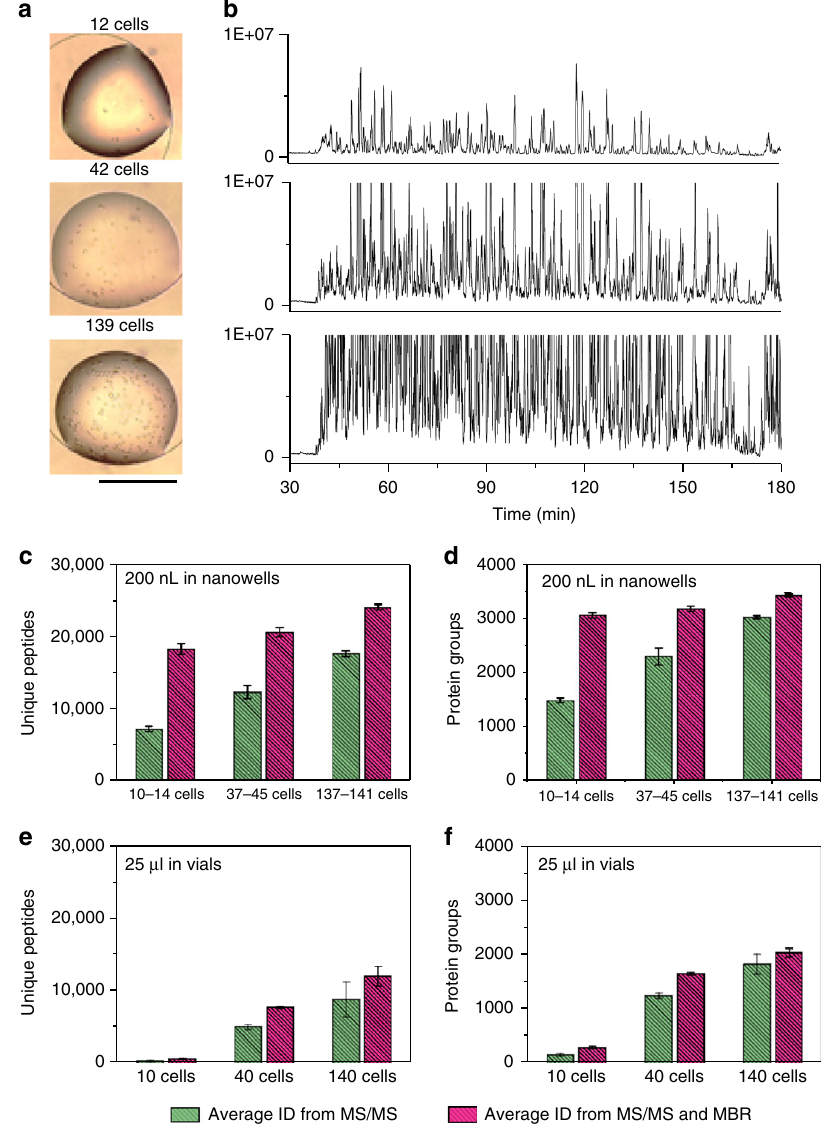
Fig. 2 Evaluation of sensitivity and reproducibility for the nanoPOTS platform. a Images of 12, 42, and 139 HeLa cells in nanowells before processing and ( b ) their corresponding base peak chromatograms. The y -axis was held constant to show signal variation with different cell loadings. c Number of unique peptides and ( d ) proteins identi fi ed from different cell loadings. Three samples containing similar cell numbers were grouped together to determine reproducibility. For the 10 – 14 cells group, the cell numbers were 10, 12, and 14 cells. For 37 – 45 cells group, the cell numbers were 37, 42, and 45 cells. For 137 – 141 cells group, the cell numbers were 137, 139, and 141 cells. e Number of unique peptides and ( f ) proteins identi fi ed from cell lysate equivalent to 10, 40, and 140 cells. The cell lysates were prepared in regular Eppendorf low-binding vials with 25 µ L of total processing volume. Data are expressed as means ± SD for experimental triplicates. Scale bar in ( a ) is 500 µ